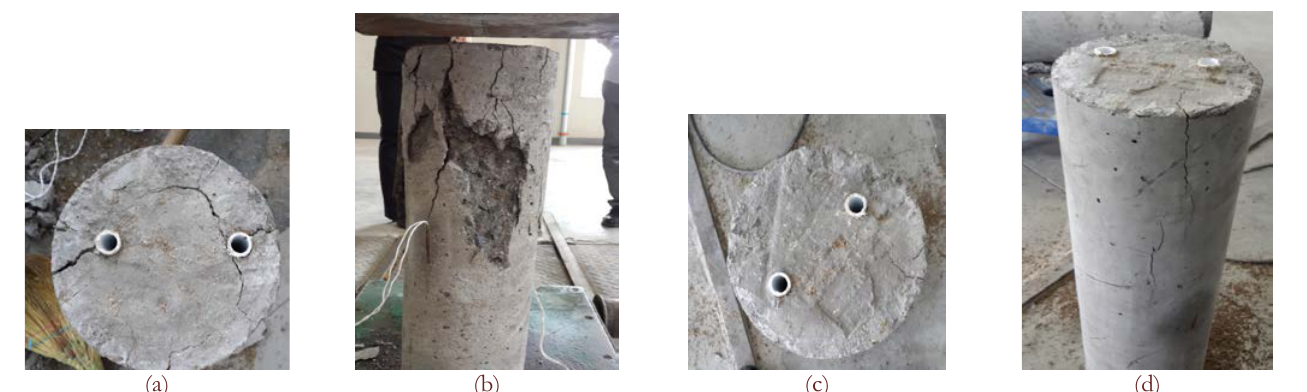
Table 7: Ultimate strength of the test piles (kN).